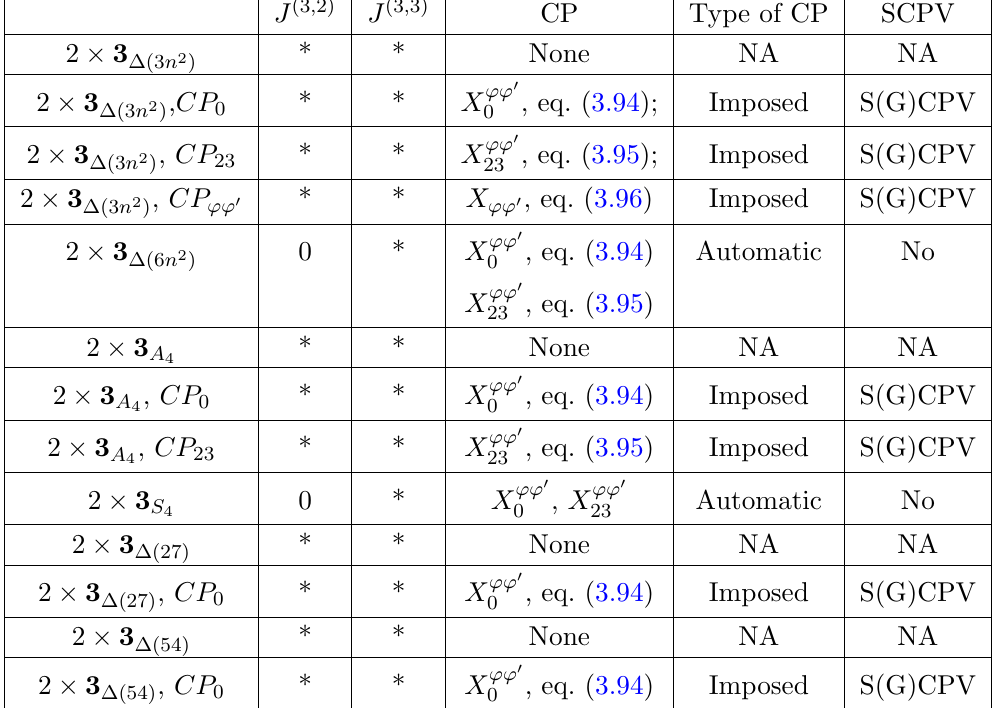
Table 7 . Summary of the value of J (3 ; 2) , J (3 ; 3) , CP symmetry transformations and whether SCPV is possible, for the 2 triplet scalar potentials analysed. The (cid:3) denotes the SCPI is non-zero for arbitrary VEVs (it may still vanish for the potential’s VEVs), NA stands for Not Applicable (SCPV is not meaningful in cases without a CP